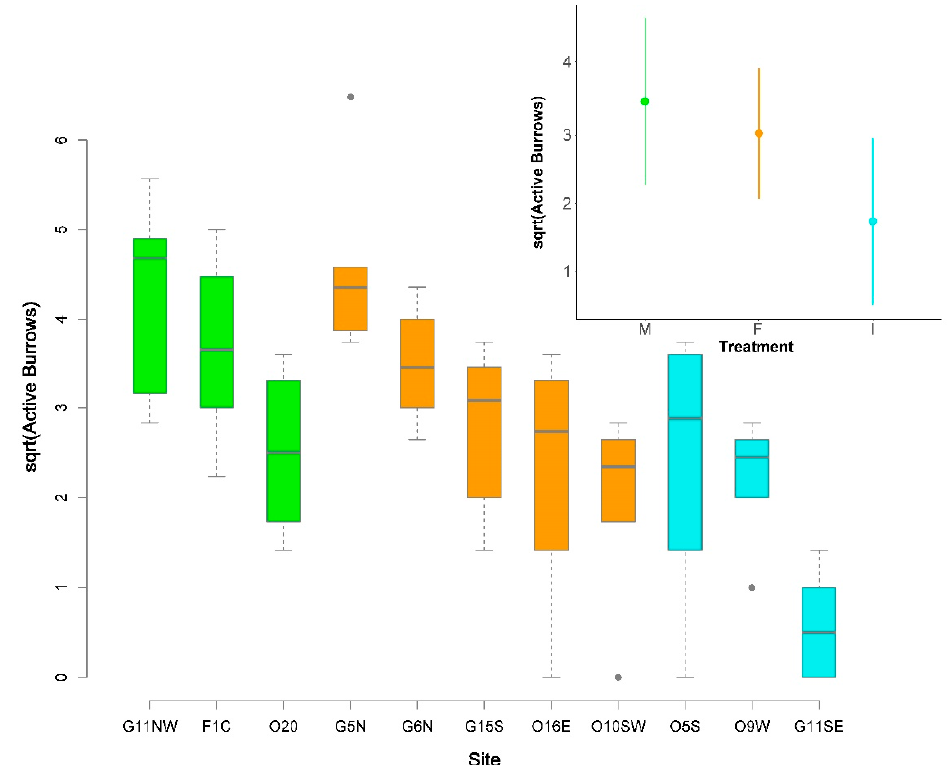
Figure 4. Boxplot of the number of active burrow openings per transect (square-root transformed) by site and treatment.